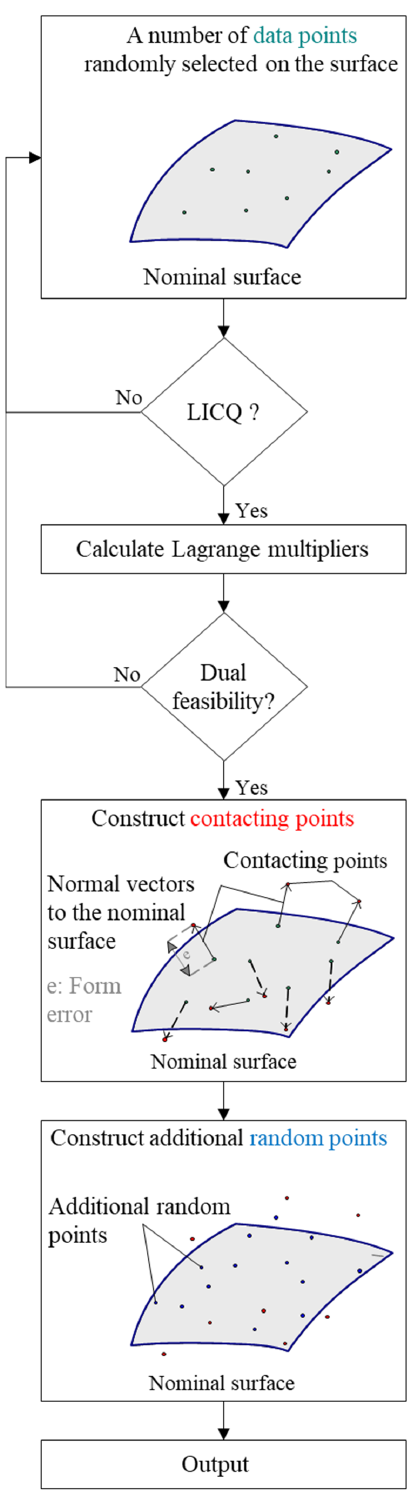
Figure 4. Flowchart describing the generation of reference softgauges for MZ fitting.